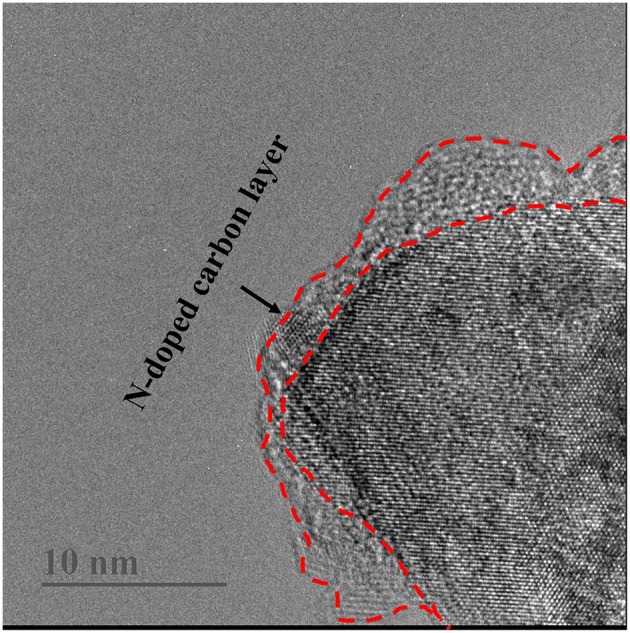
TEM image of Li4Ti5O12@CN composite.